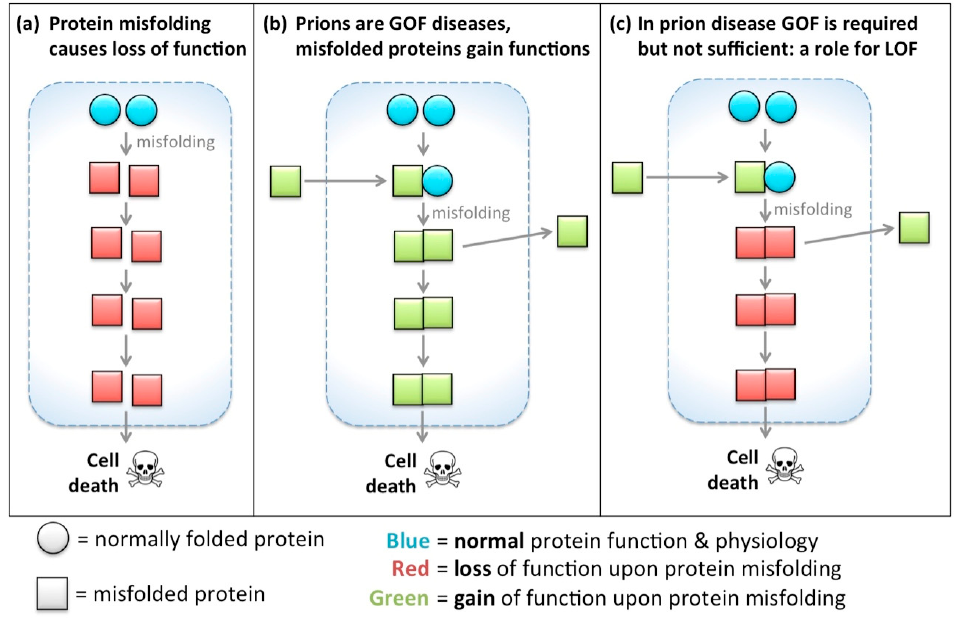
Figure 2. Gain-of-function concepts dominate the prion field, but a protein’s functions are also lost when it is misfolded. Simplified schematic to represent the hypotheses regarding proteins that exhibit gain-of-function (gain of function (GOF): labelled “green for gained/go”) when they misfold/aggregate. In other instances, protein misfolding leads to a reduction, subversion or loss of function (loss of function (LOF): labelled “red for reduced/stop”). ( a ) Upon misfolding, proteins lose their